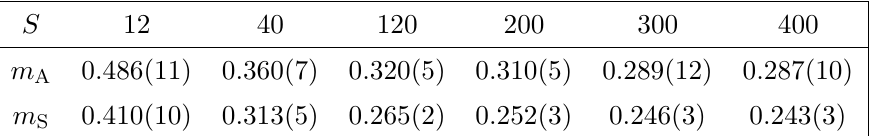
Table 9. Extracted masses for di(cid:11)erent smearing levels S for the symmetric and antisymmetric gluino-glueball states for (cid:12) = 17 and m f = (cid:0) 0 : 1415.